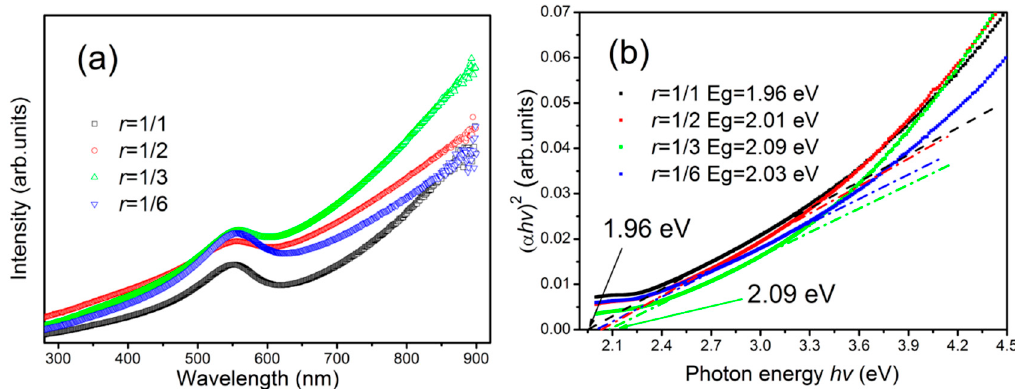
Figure 5. UV-vis transmission spectra of the Cu 3 N films prepared at different r ( a ), and determination of the optical band gap of the films ( b ).